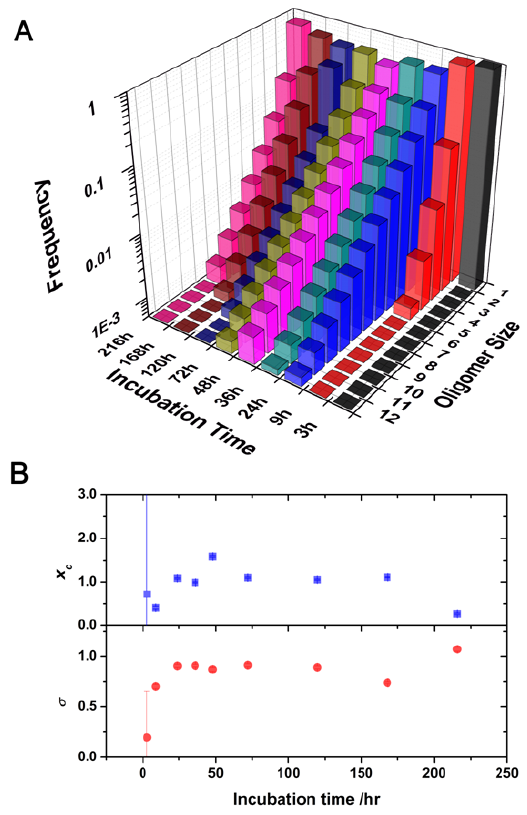
Figure 4. ( A ) Oligomer size distributions as a function of incubation time. ( B ) Plot of the fitting parameters x (top) and σ (bottom) of the log-normal distributions in Figure c